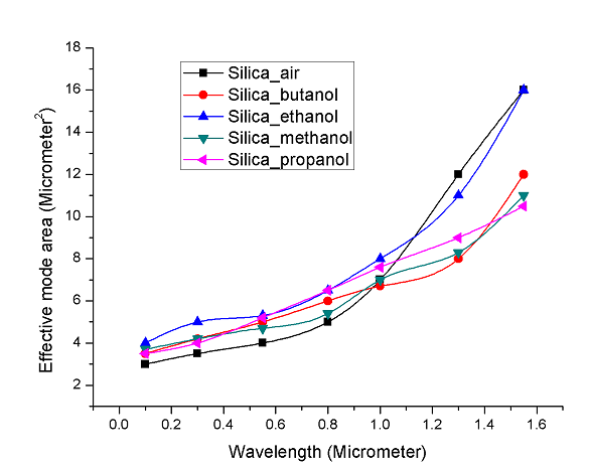
Figure 4: Effective mode area at different wavelengths In designing single mode fiber size of fundamental mode plays a vital role. The same can be named as effective mode area. It relates to the effective area of the fiber core. Effective mode area, relevance to losses like bending loss, confinement loss and splice loss and numerical aperture is considered to be a significant parameter for studying modal characteristic. Large effective mode area is needed for the transmission of high power. Small mode area PCFs are preferred when desired to enhance nonlinear properties of fiber. In other words, effective mode area is a measuring parameter of nonlinear properties of fiber.